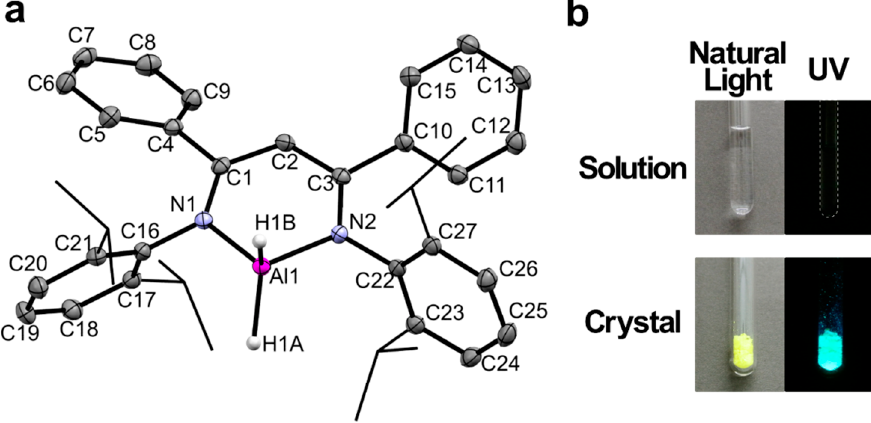
Figure 1. ( a ) Oak Ridge Thermal Ellipsoid Plot (ORTEP) (50% ellipsoids) of compound LAlH . For clarity, isopropyl groups were shown in wireframe and hydrogen atoms were omitted except for those at the aluminum atom. Key to atom colors: carbon, gray; aluminum, magenta; nitrogen, blue; and hydrogen, white. ( b ) Photographic images of the 2-methylpentane/toluene (99/1) solution (1 × 10 − 5 M) and the crystals under natural light (left) and UV irradiation (right). Table 1. Selected structural parameters of LAlH in the single crystal. Distances